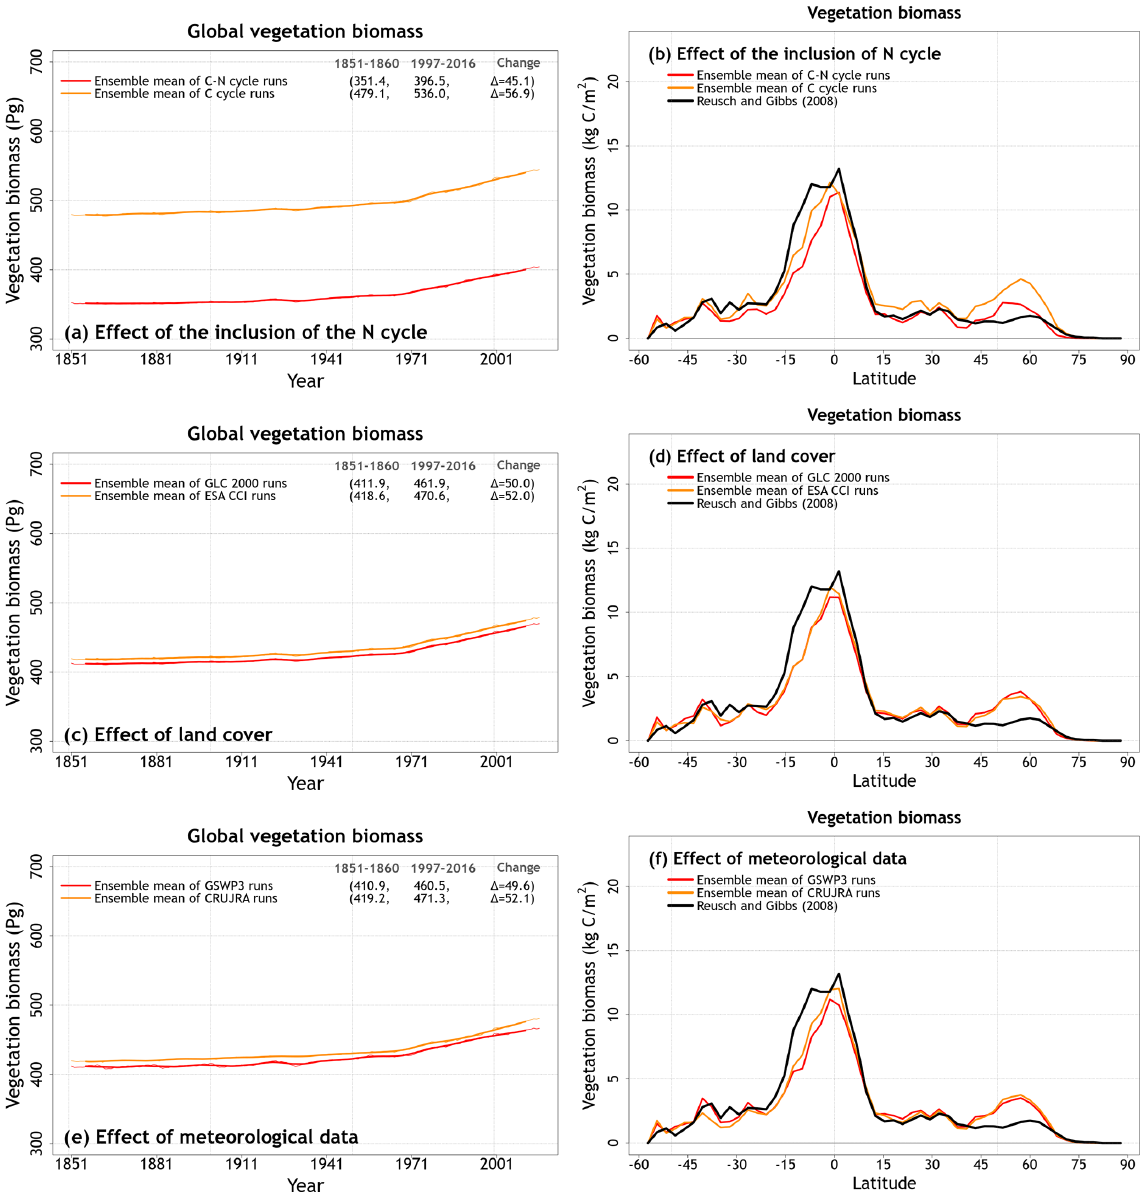
Figure 5. Time series of annual global vegetation C mass (over all land area excluding Greenland and Antarctica) (a, c, e) and zonally averaged values of vegetation C mass over land (b, d, f) averaged, for the period 1997–2016, over the four ensemble members that are driven with and without an interactive N cycle (a, b) , that are driven with the GLC-2000- and ESA-CCI-based land cover (c, d) , and that are driven with GSWP3 and CRU-JRA meteorological data (e, f) . The thin lines for the time series show the individual years, and the thick lines show their 11-year moving average. Model values averaged over the pre-industrial (1851–1860) and present-day (1997–2016) time periods, and their difference, are also shown in (a, c) and (e)